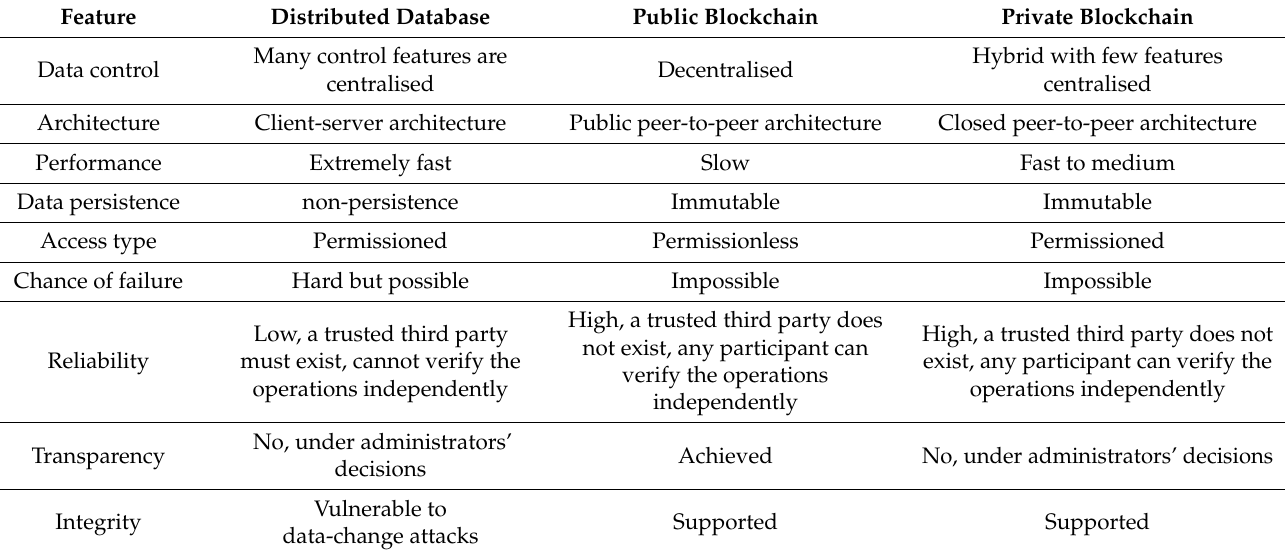
Table 2. Blockchain vs. distributed database